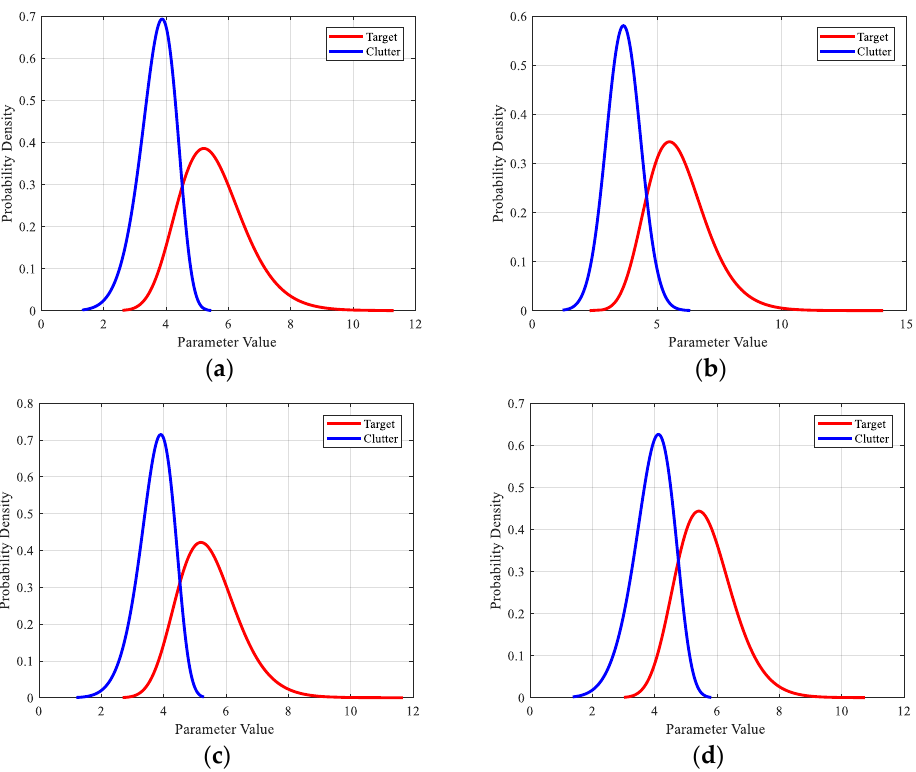
Figure 5. PDF fitting curves for the different feature parameters of insect targets and clutter: ( a ) d ,